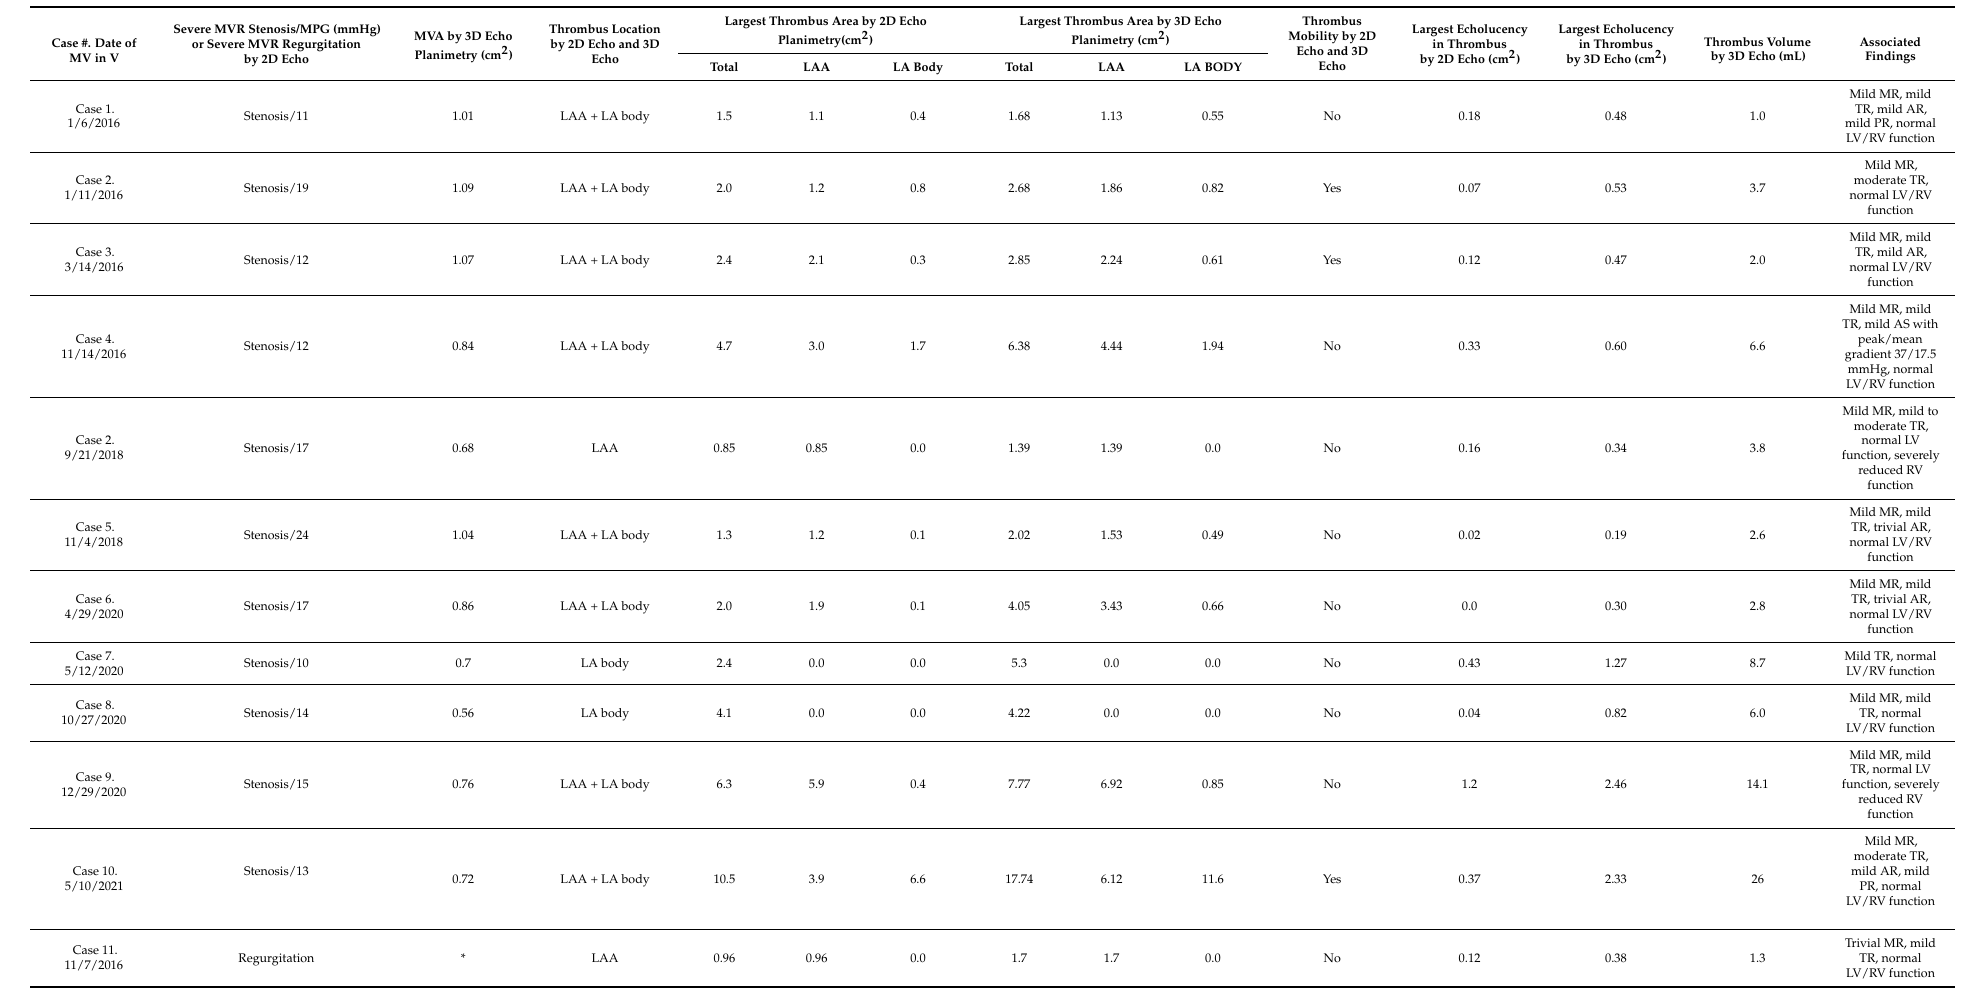
Table 2. Two- and three-dimensional transesophageal echocardiographic